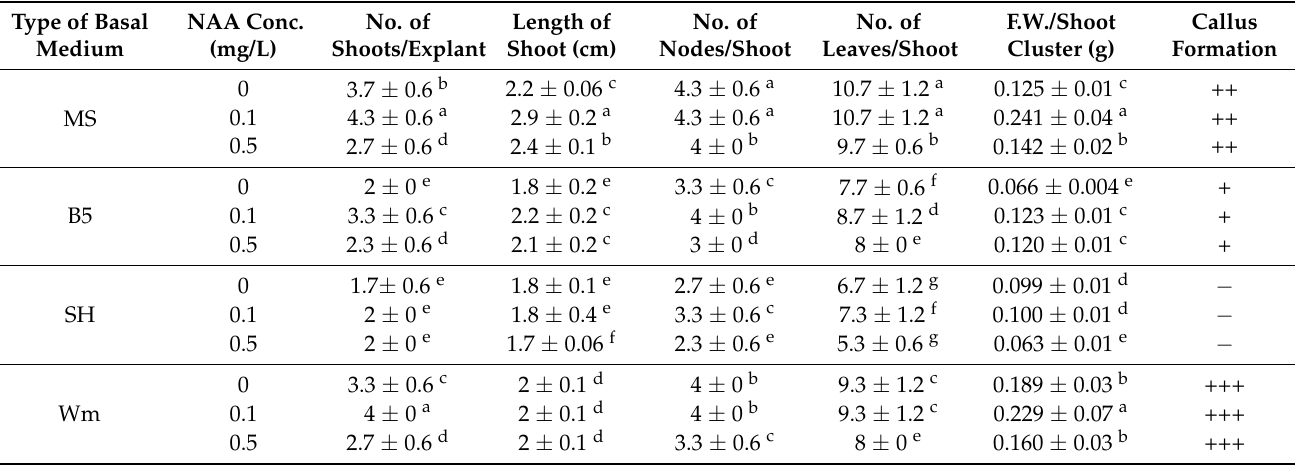
Table 2. Effect of different NAA concentrations in combination with 2 mg/L BAP in different basal media types on in vitro shoot multiplication and growth of paulownia for one month.